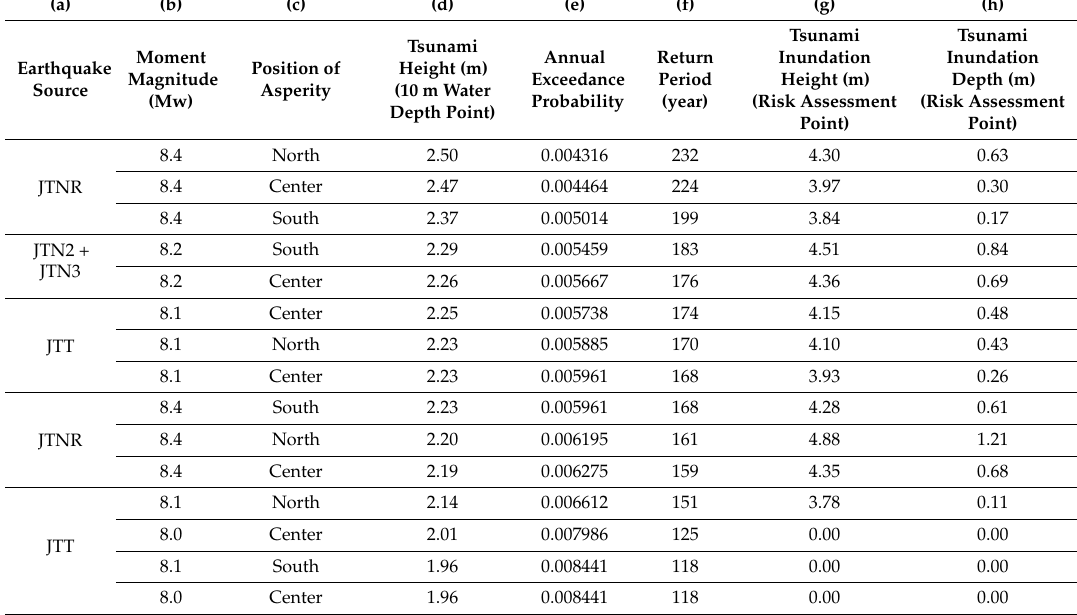
Table 7. Calculation results for Sendai. (a) Earthquake source name; (b) moment magnitude of the earthquake; (c) position of the asperity; (d) tsunami wave height at a water depth of 10 m; (e) annual exceedance probability estimated using the tsunami hazard curve; (f) return period calculated from the annual exceedance probability; (g) tsunami inundation height at the risk assessment point simulated using a nonlinear longwave equation with the fault